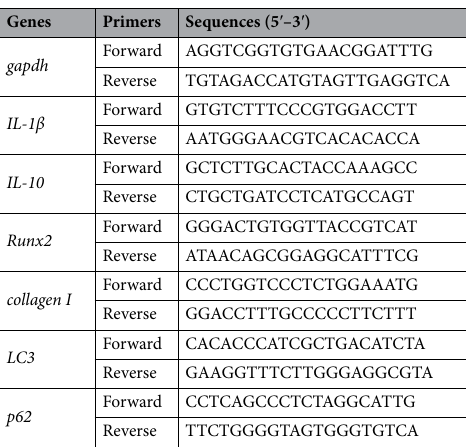
Table 1. List of primers used in this study for